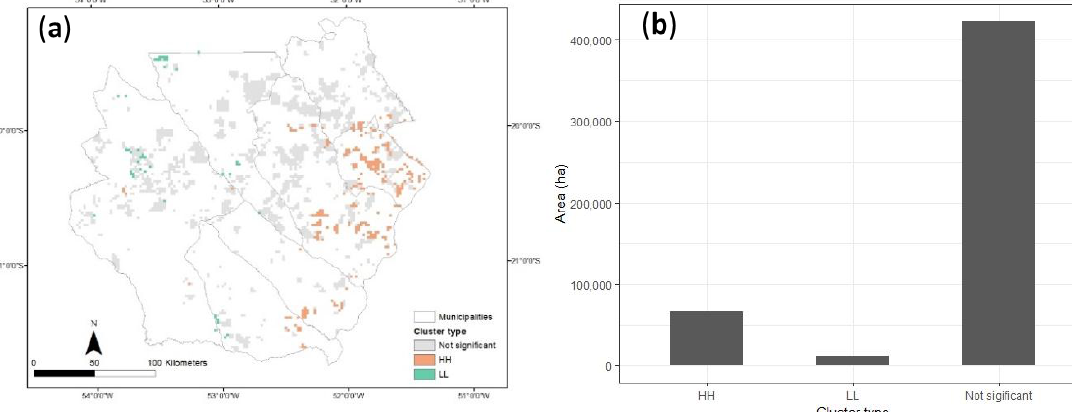
Figure 9. ( a ) Eucalypt expansion areas over fire likelihood occurrence cluster type over in the study period (2010–2016). ( b ) Distribution of eucalypt expansion area (ha) in the study period (2010–2016) classified by cluster type.